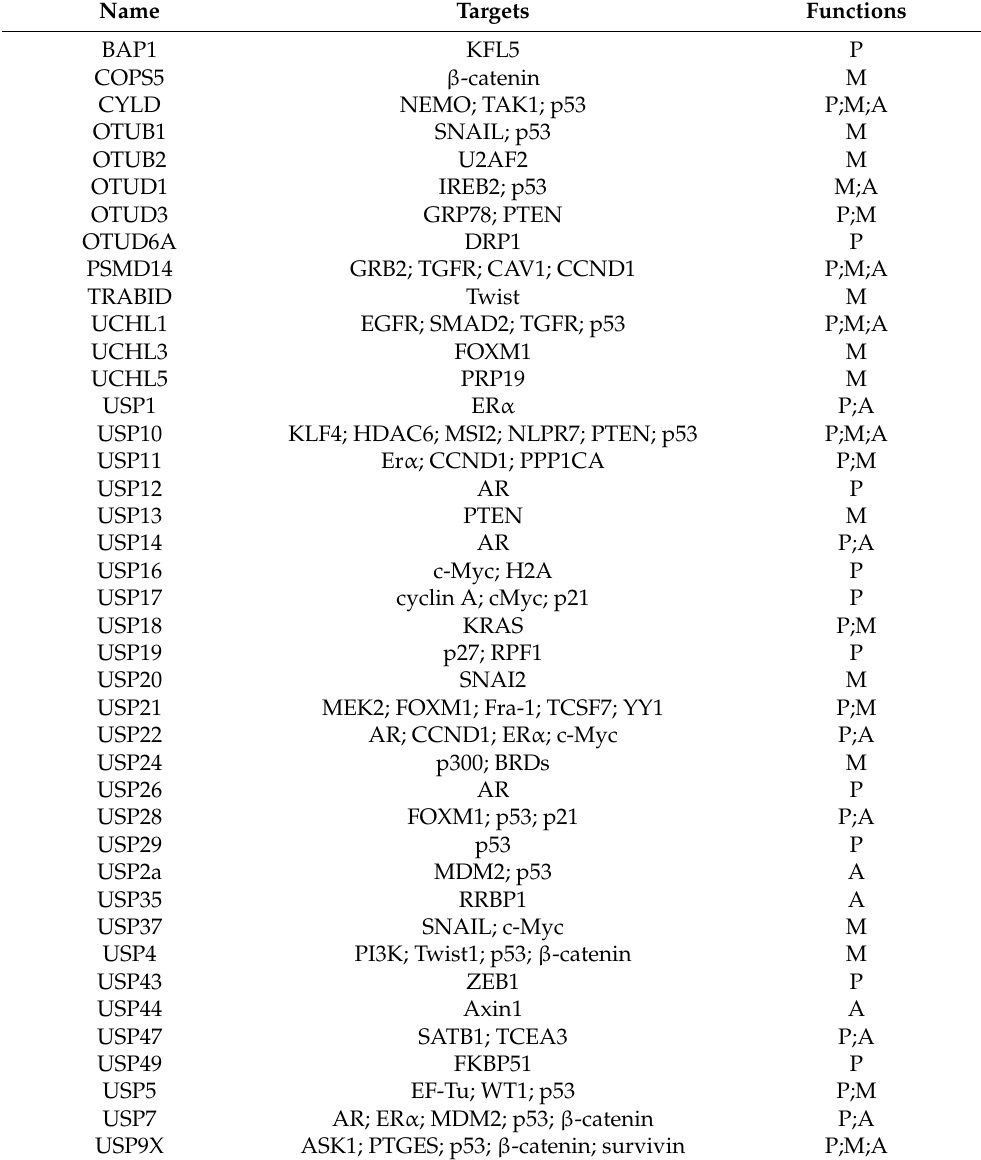
Table 1. Targets of selected DUBs and their roles in cancers. P indicates the proliferation, M is metastasis, and A represents